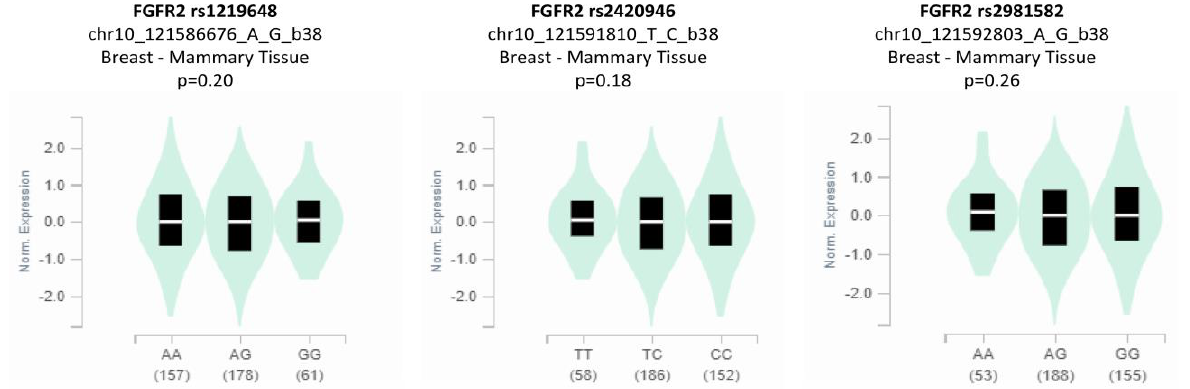
Figure 4. Genotype-based mRNA expression of FGFR2 rs1219648, rs2420946, and rs2981582 poly-